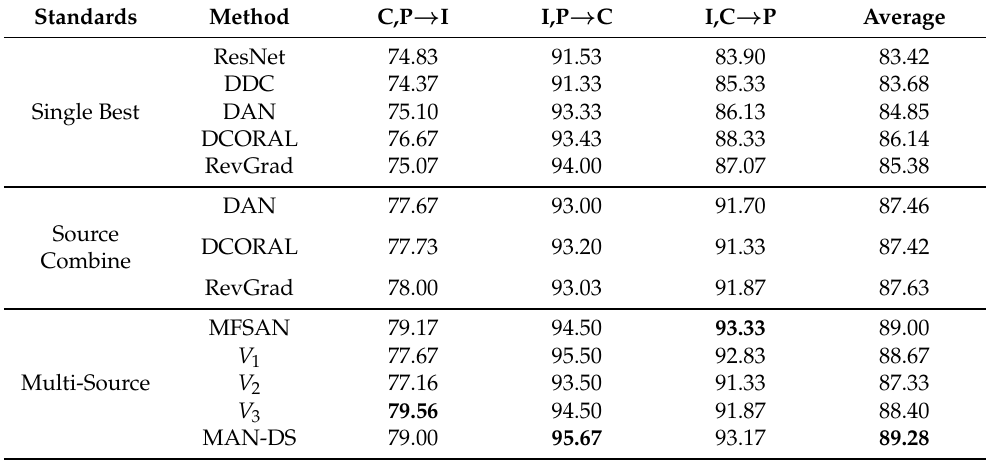
Table 2. Performance comparison of classification accuracy (%) on Image-CLEF dataset. Standards